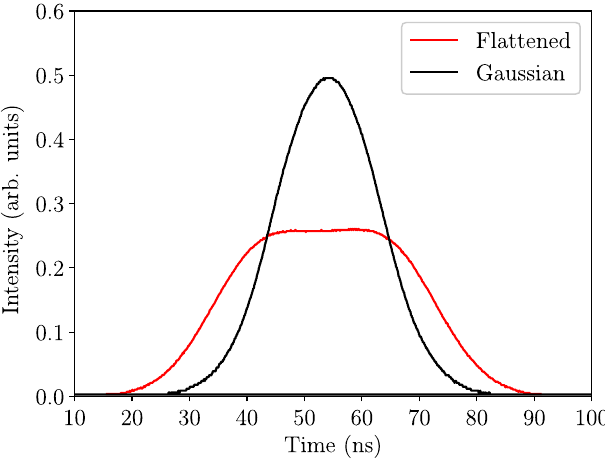
FIG. 14. Nominal chromaticity settings at various energies during BES-II, required to suppress the coupled bunch